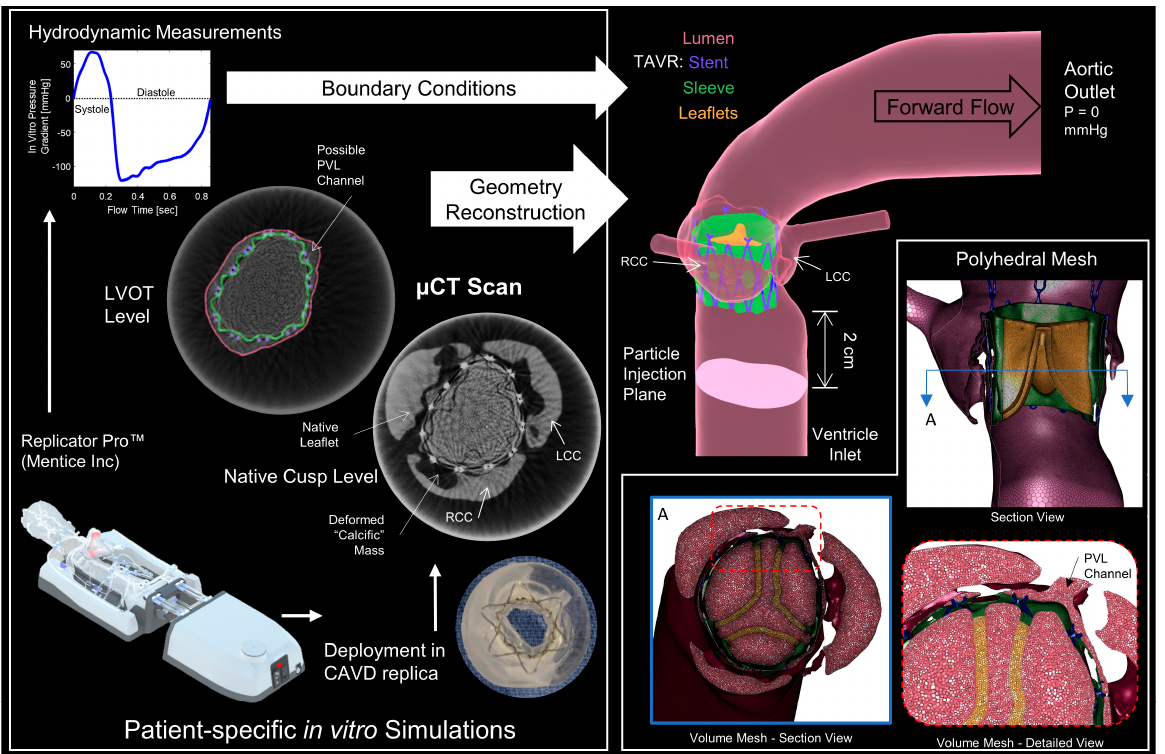
Figure 1. Creation of CFD domain and mesh from µCT scans of in vitro models—Left box—the process of obtaining patient-specific boundary conditions from hydrodynamic studies and segmen- tation of µCT models (colored to show components). Top right—final sample reconstructed CFD domain. Bottom right box—Polyhedral mesh showing the resolution within the PVL channels and cell volume distinction.